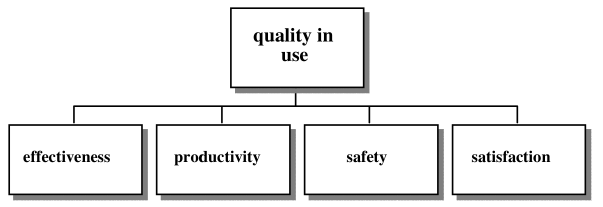
Figure 2. Quality model for quality in use